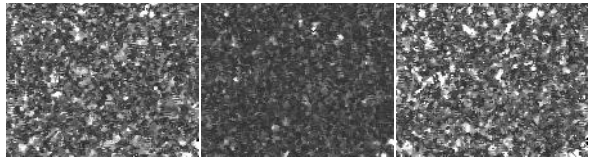
Figure 12. Single DEMs from bands (2,3), (2,4) and (3,4) for the City center of Frankfurt am Main, 1500 × 1200 m 2